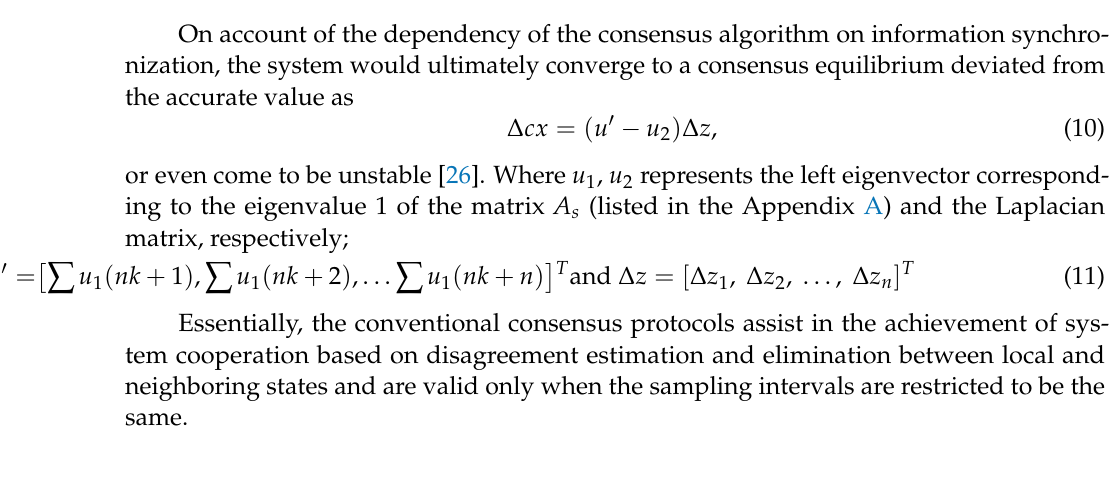
Figure 2. Schematic diagram of asynchronous communication.